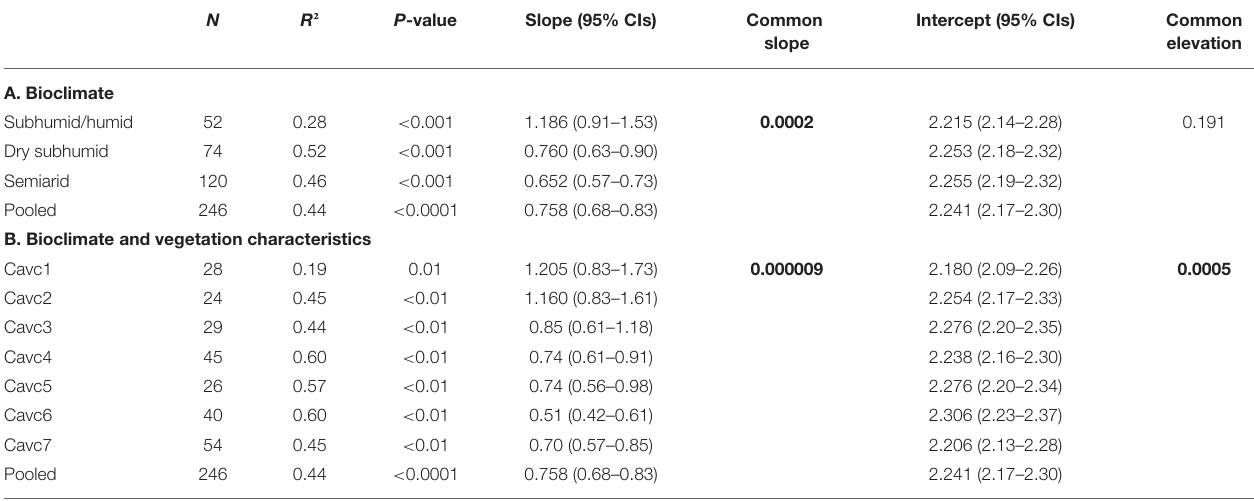
TABLE 4 | Log–log relationships between SVS and BD for the studied samples grouped according to their climatic context (A) and to their climatic and vegetation characteristics (B) . N